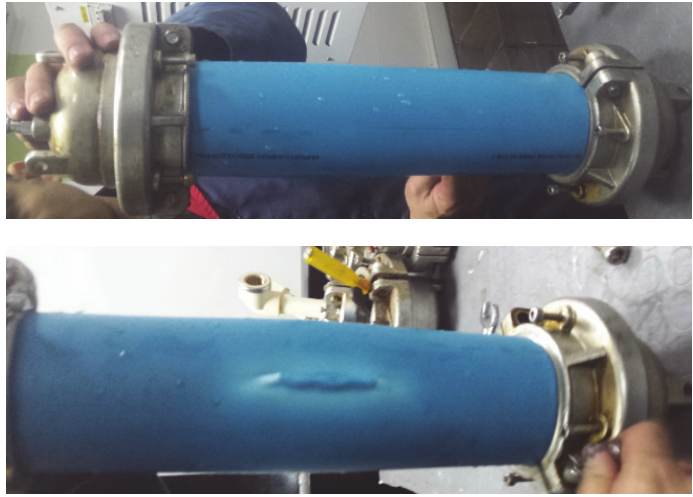
Figure 3: Rupture of PPR